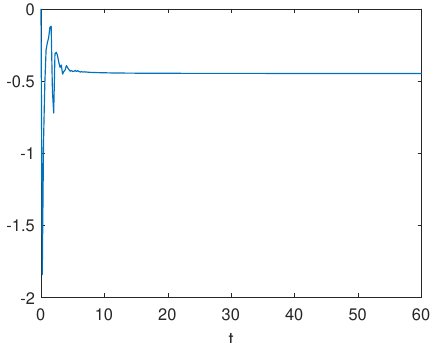
1, t ) obtained for ∆ x = ∆ t = 0.2. − ˜ ψ ( ) ) ψ ∞ ( ψ ∞ ( , 100 ) / between the ap- (cid:107) · − · (cid:107) H 0 ( Γ ) (cid:107) · (cid:107) H 0 ( Γ )